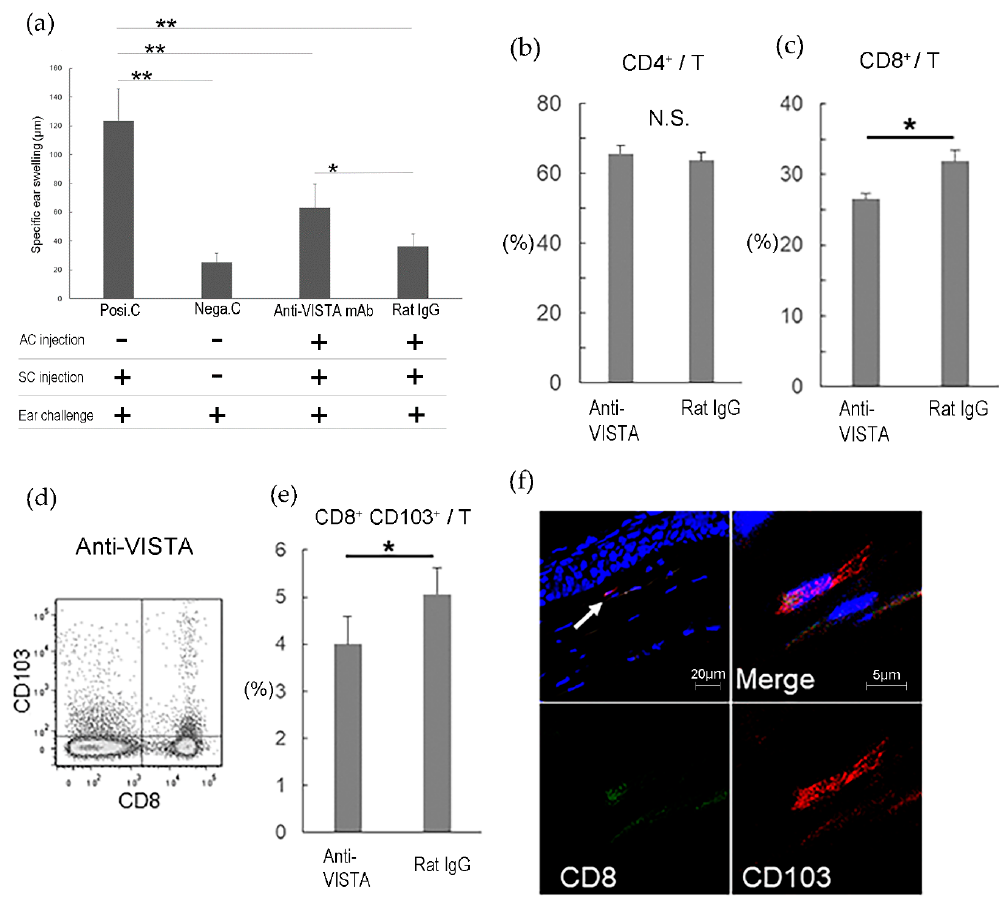
Figure 3. VISTA is involved in the induction of eye-derived tolerance “ACAID” via CD8 + CD103 + T cells. C57BL/6 spleen cells were used as allo-antigens and injected into the right anterior chamber (AC) of normal eyes of mice treated with anti-VISTA mAb or rat IgG. Two weeks later, C57BL/6 spleen cells were injected subcutaneously to sensitize the mice. After one more week, a challenge was conducted by injecting C57BL/6 spleen cells into the right ear pinna of each mouse, and specific ear swelling was measured 24 h later as an indication of delayed-type hypersensitivity. Positive control mice (Posi.C) received subcutaneous immunization and ear challenge without previous AC injection. Negative control mice (Nega.C) received only the ear challenge without AC injection or immunization. ( a ) shows the results of ACAID induction. ( n = 6 per group). Data were analyzed using the two-tailed Student’s t -test. “SC” denotes subcutaneous. Seventy-two hours after induction of ACAID, expression of CD4, CD8, and CD8/CD103 in T cells from the spleen of ACAID model mice treated with anti-VISTA mAb or rat IgG was examined with flow cytometry. ( b ) shows the proportion of CD4 + T cells among T cells. ( c ) shows the proportion of CD8 + T cells among T cells. ( d ) shows representative flow cytometry data of CD8 + CD103 + T cells, and ( e ) shows the proportion of CD8 + CD103 + T cells among T cells. ( f ) Cryostat sections of surviving corneal allografts at 3 weeks were stained with FITC-conjugated anti-CD8 mAb (green) and PE-conjugated anti-CD103 mAb (red). Nuclei were stained with DAPI (blue). The arrow shows the CD8 + CD103 + cells, and a double-positive cell at higher magnification is shown. Data are the mean ± SD of three experiments per group. * p < 0.05, ** p < 0.005, N.S.; not significant. Data were analyzed using the two-tailed Student’s t -test. Reprinted from Invest Ophthalmol Vis Sci, 60, 4958–4965. Kunishige T; Taniguchi H; Ohno T; Azuma M; Hori J. VISTA Is Crucial for Corneal Allograft Survival and Maintenance of Immune Privilege. (2019) with permission from IOVS [30].